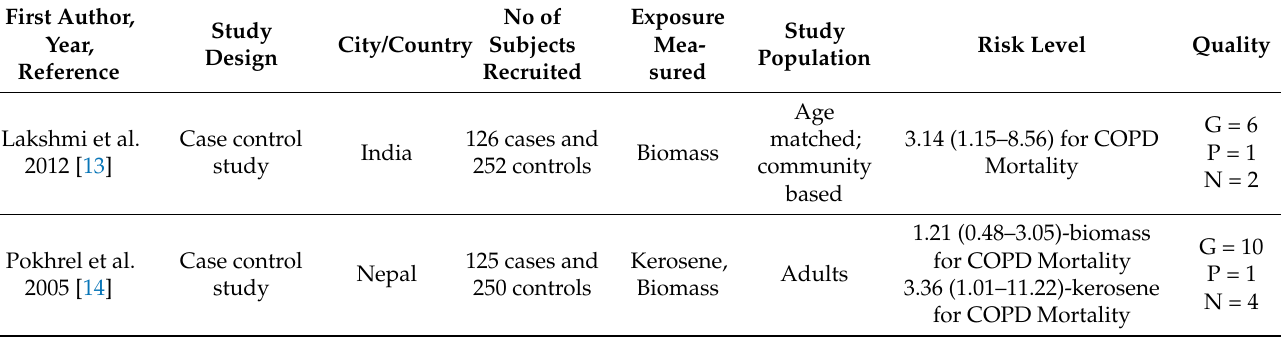
Table 3. Odds ratios of studies showing COPD